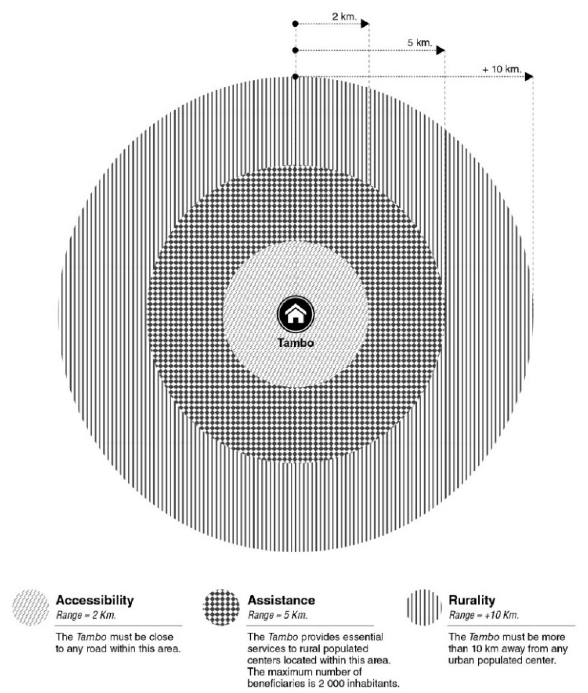
Figure 5. Main characteristics of the population benefited by the tambos (source: author, elaboration with data from Chumacero , 2015